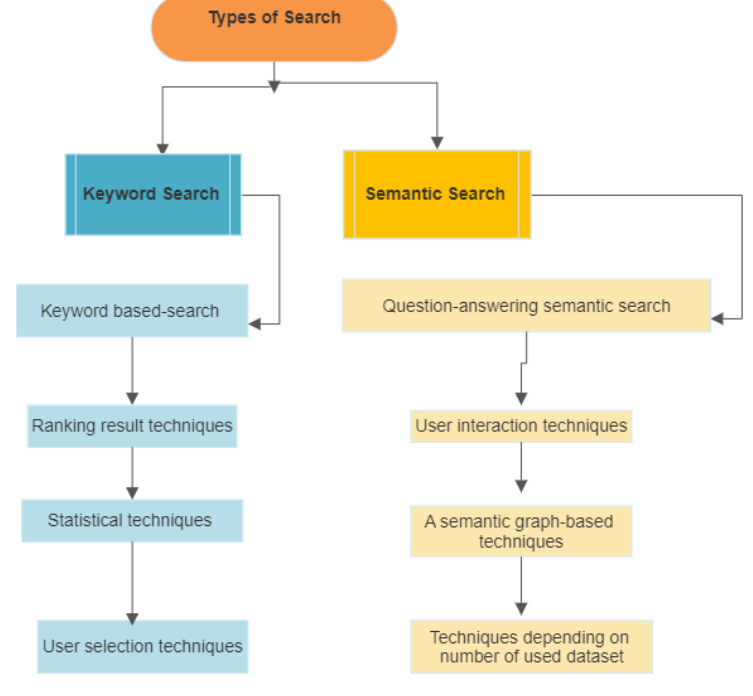
Figure 1. Types of